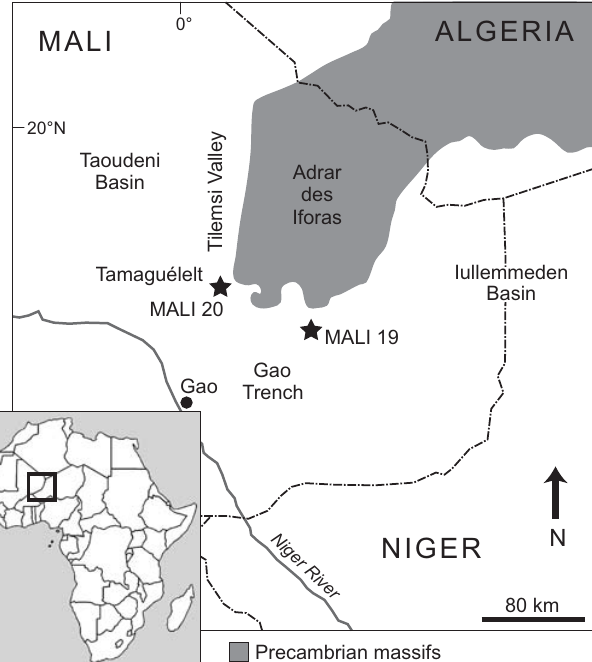
Fig. 2. Map of the field area in eastern Mali with the relative locations of the snake bearing